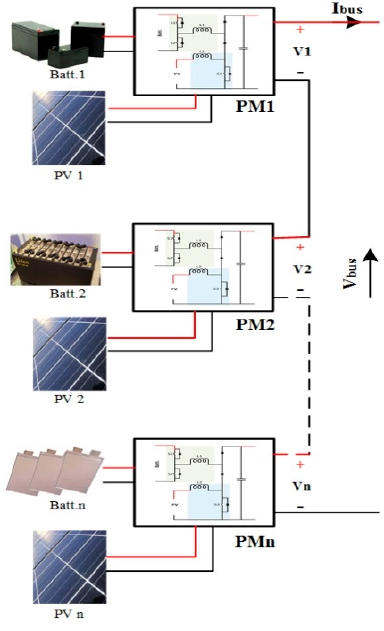
Figure 2. The proposed modular multiport converter architecture.